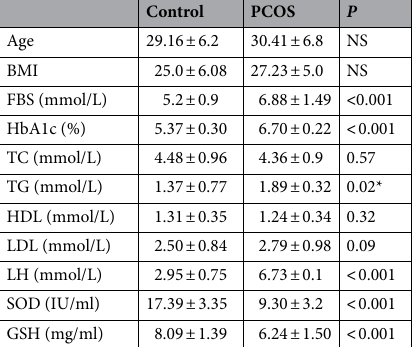
Table 2. Biochemical characteristics and antioxidant status of the study groups. NS, non-significant. * p ≤ 0.05.